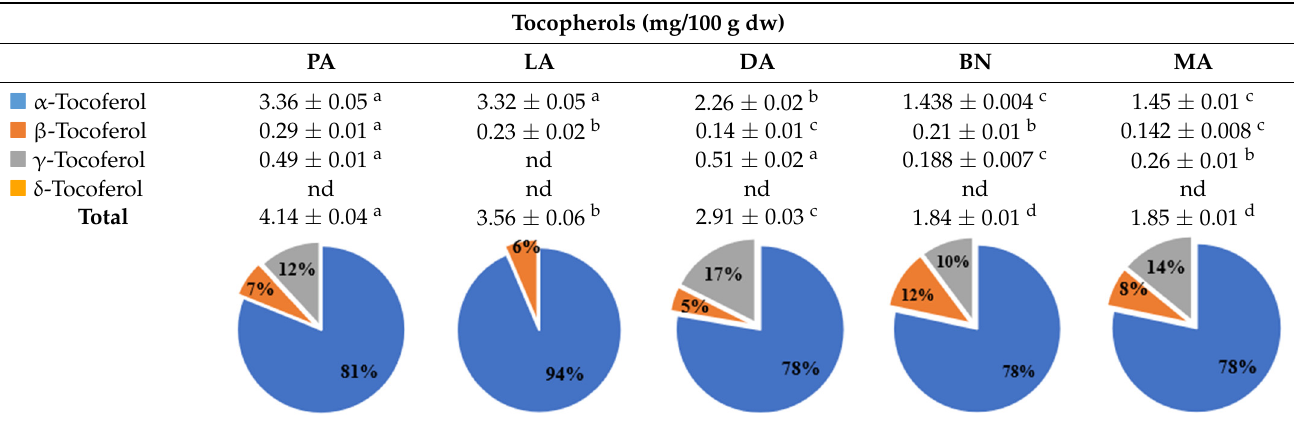
Table 4. HPLC-FL determination of tocopherol content of fig leaves. Tocopherols (mg/100 g dw)